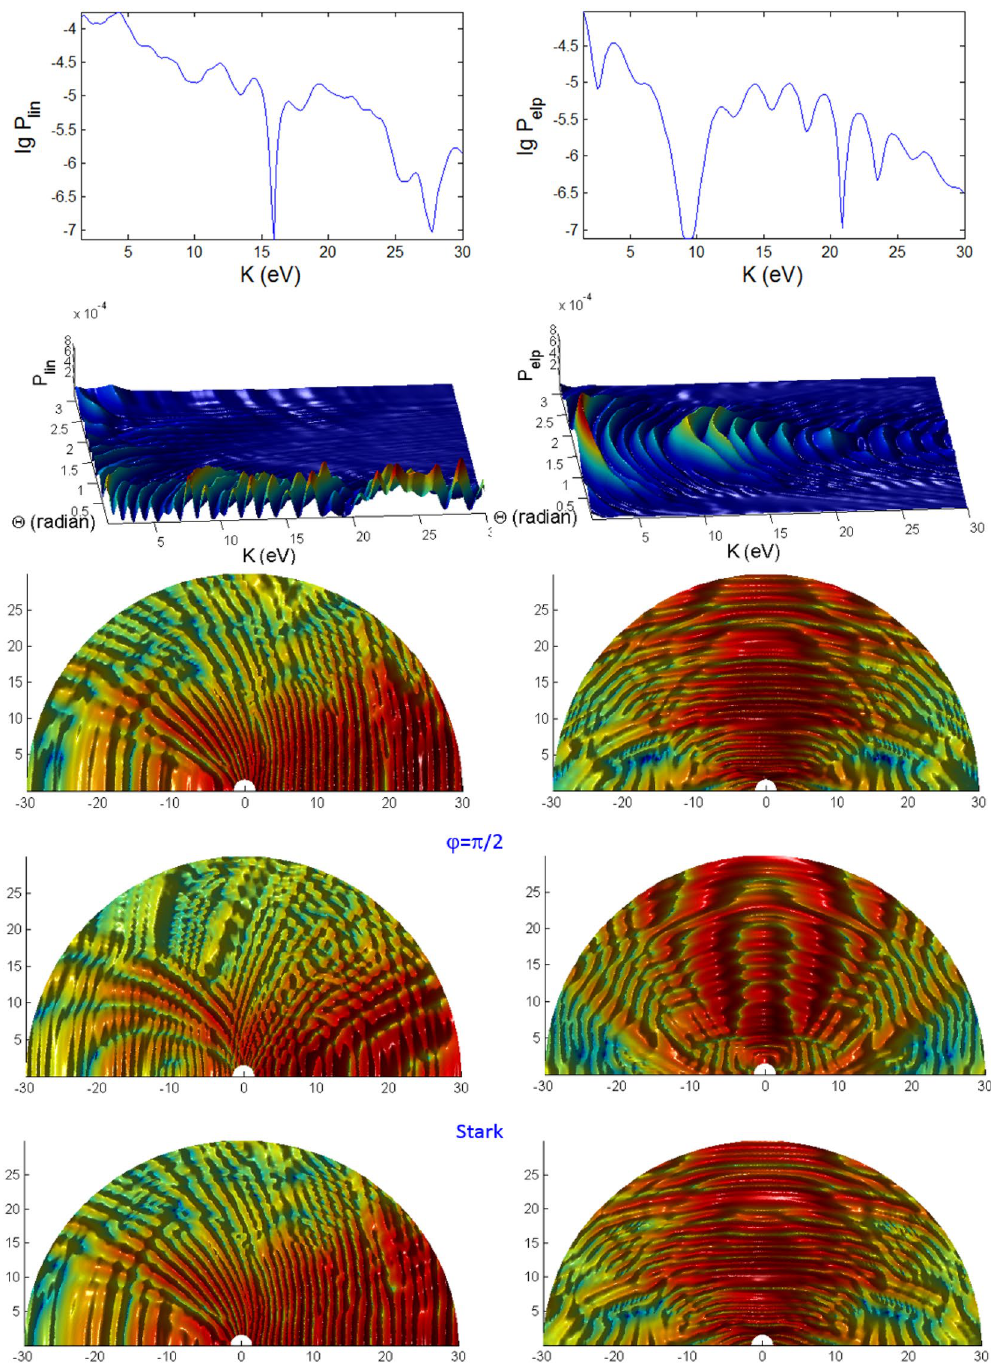
Figure 13. Same as Fig. 12 (photoionization probability for t p = 10 fs, versus Θ at Φ = 0 and K ) but for case B characterizing the ATI